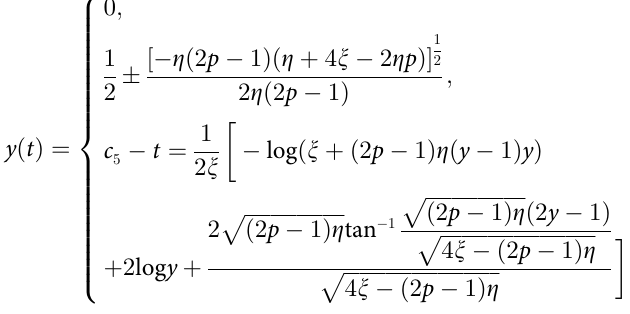
ð 2 y (cid:0) 1 Þ